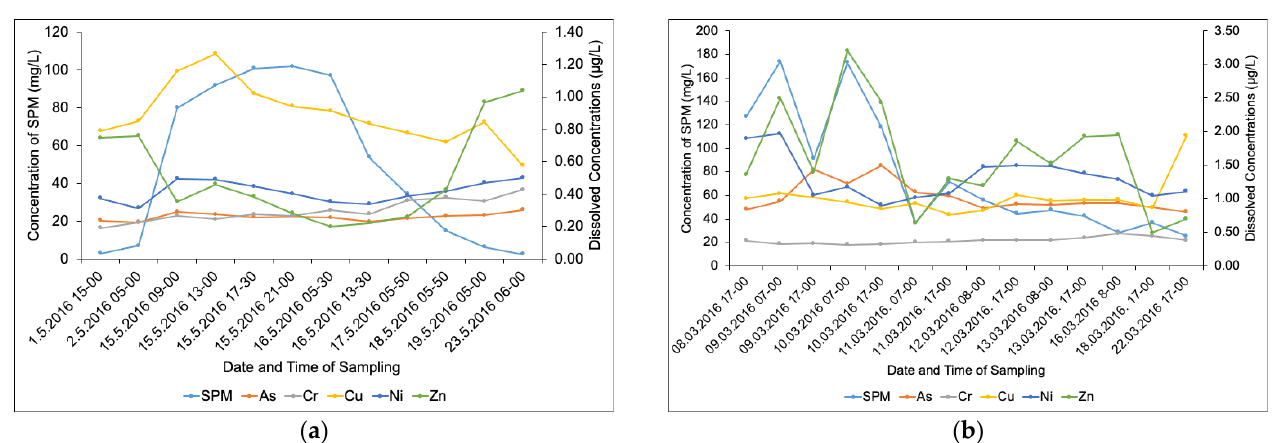
Figure 4. Relationship between SPM concentration and dissolved PTE at ( a ) Litija and ( b ) Belgrade sampling sites.